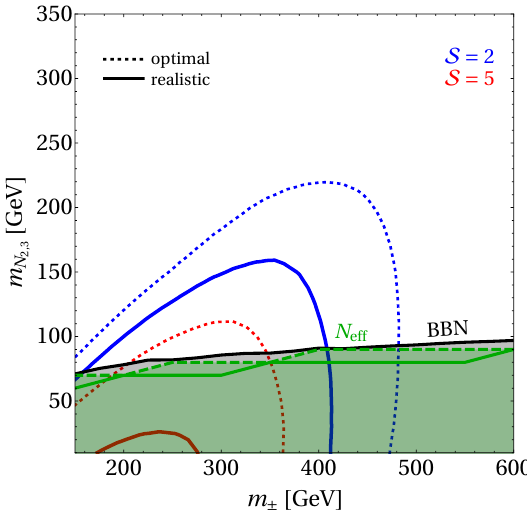
Figure 7 . Projected sensitivities for HL-LHC using = 4000 fb (cid:0) 1 and the same analysis techniques L as in ref. [56]. Given in blue are exclusion limits, = 2, and shown in red are discovery limits, S where = 5. The dashed lines correspond to a 100% branching ratio into tau leptons, whereas the S solid lines represent the case in which the maximized branching ratio for NO (shown in table 3) is employed. HNL masses in the black shaded region are in con(cid:13)ict with BBN constraints discussed in section 3.4 and the green lines arise from N e(cid:11) limits: the dashed green line indicates conservative and the solid one represents aggressive limit, as discussed in section